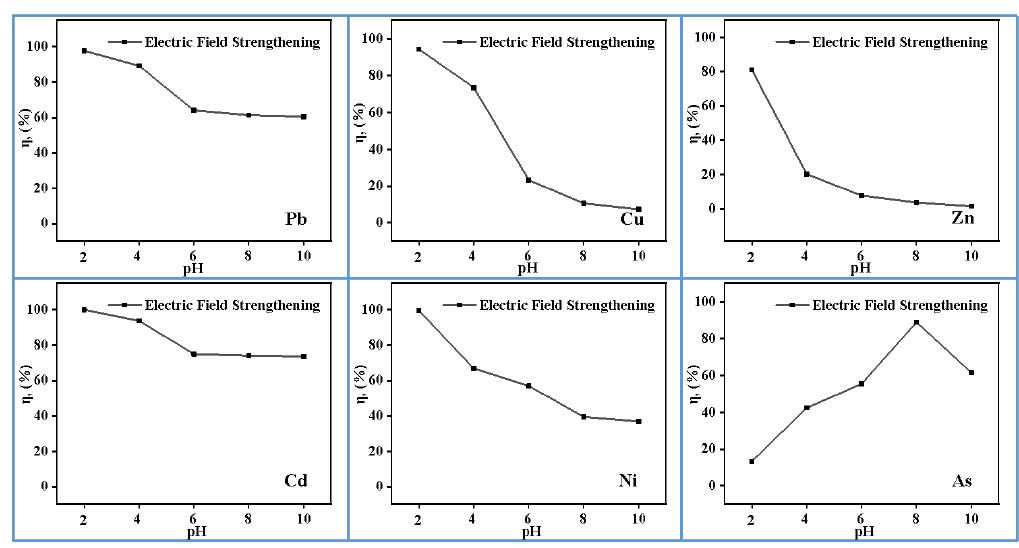
Figure 4. Effect of pH on heavy metals efficiency (0.5 mol/L EDTA, 25 mA/cm 2 , 4 h, 0 Hz).